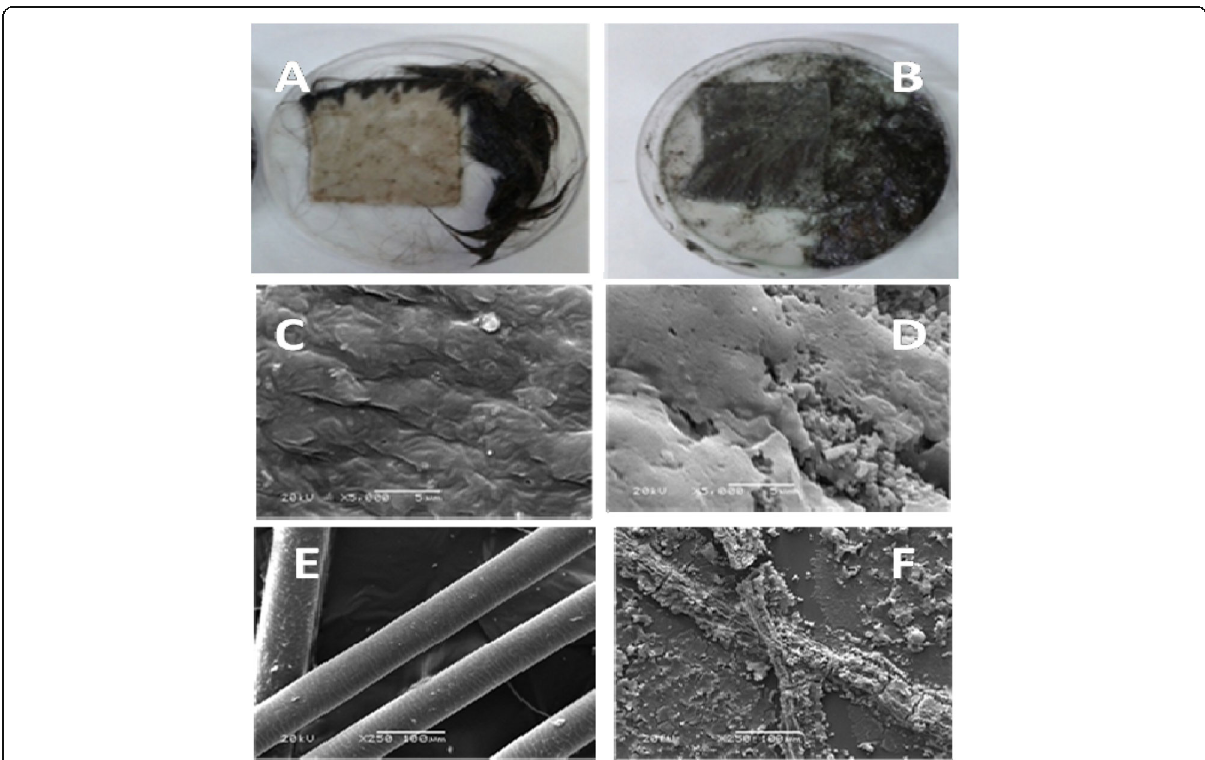
Fig. 5 Dehairing efficiency of crude protease/ keratinase ( a ) and lime-sulfide ( b ). SEM examination (× 40) for skin surface ( c , d ) and released hairs ( e , f ) upon using crude protease/keratinase and lime-sulfide mixture,